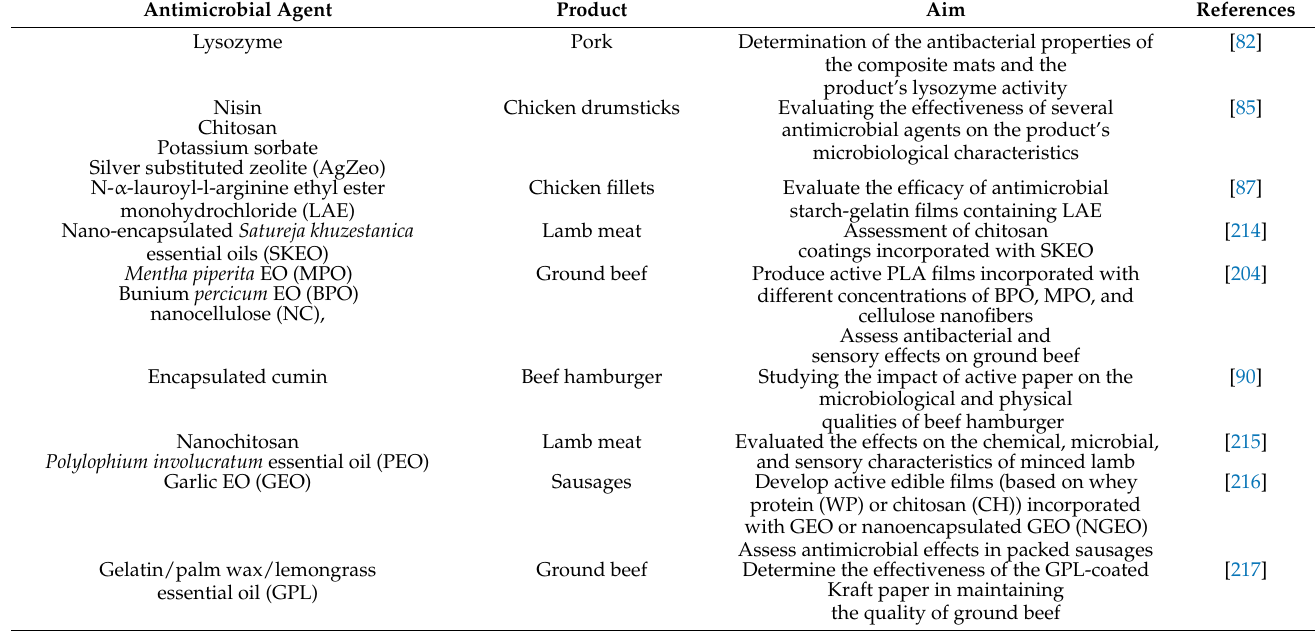
Table 5. Antimicrobial packaging and its application for meat